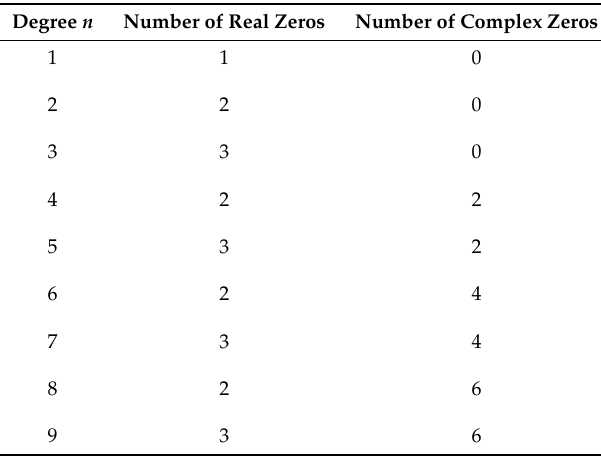
Table 5. The numbers of real and complex zeros of C B